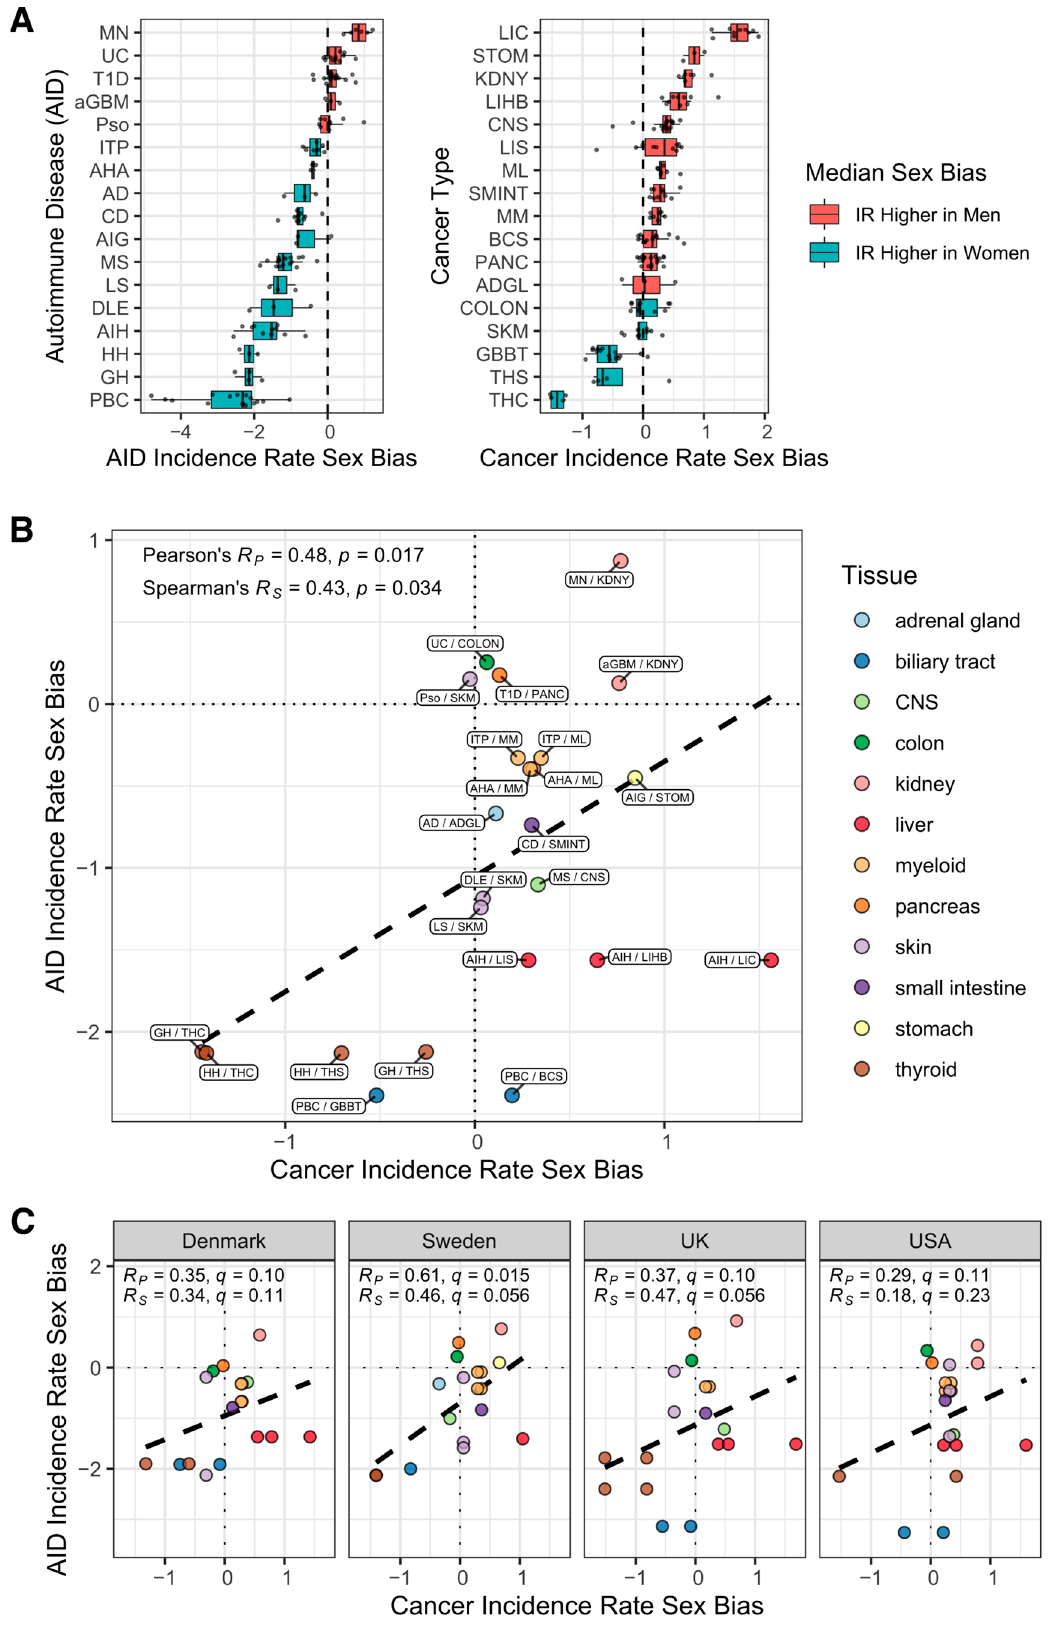
Figure 1. Incidence rate sex biases for cancers and AIDs are positively correlated across tissues of origin . ( A ) Distribution across countries of incidence rate sex bias ( x -axis) for 17 AIDs and 17 cancer types ( y -axis). All data points are shown. Box shows interquartile range (IQR, first quartile to third